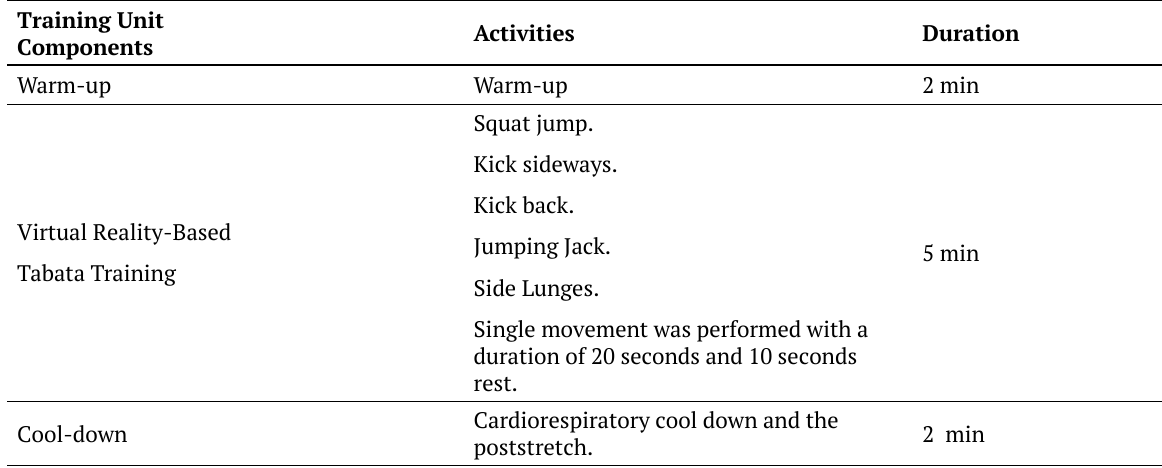
Table 1. Virtual Reality-Based Tabata Training Program Training